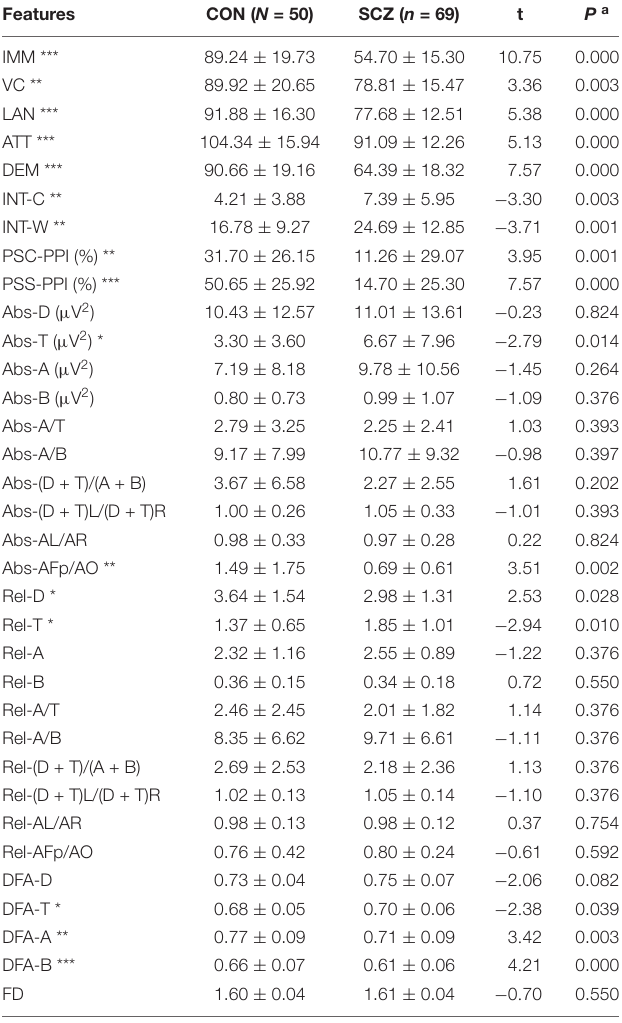
TABLE 2 | Statistical comparison of neurocognitive and electrophysiological features.